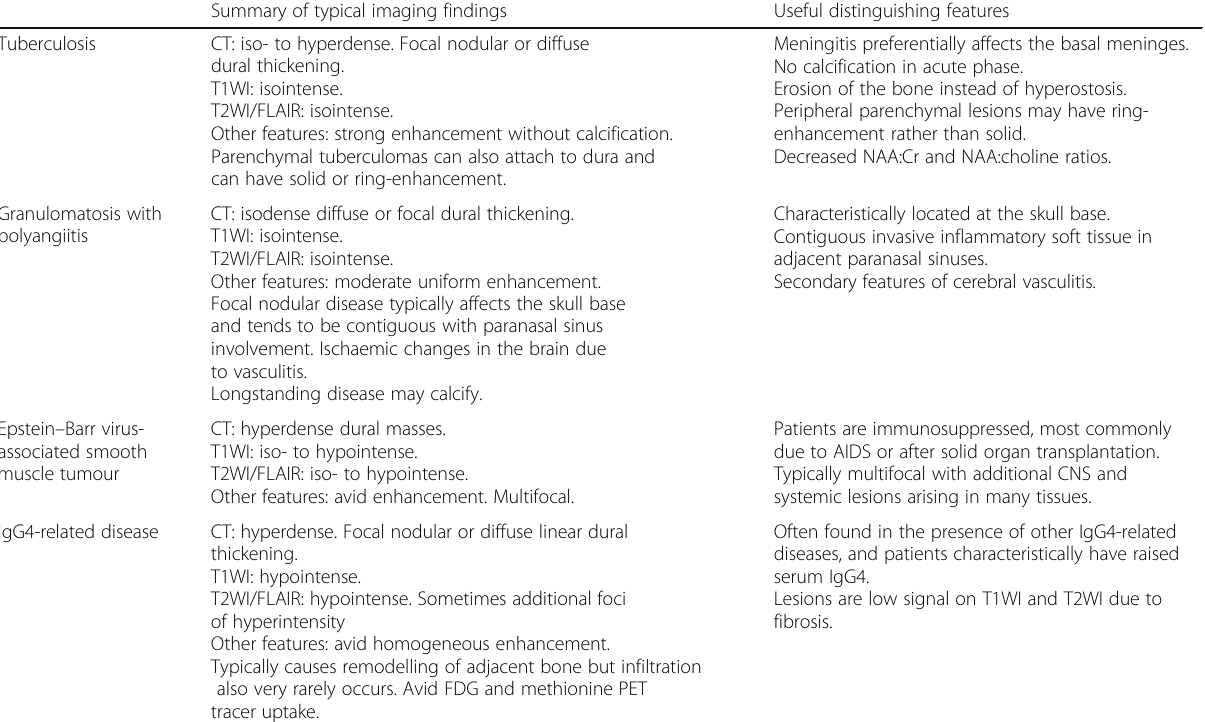
Table 2 Summary of the imaging findings in meningiomas and their mimics (Continued) Summary of typical imaging findings Useful distinguishing